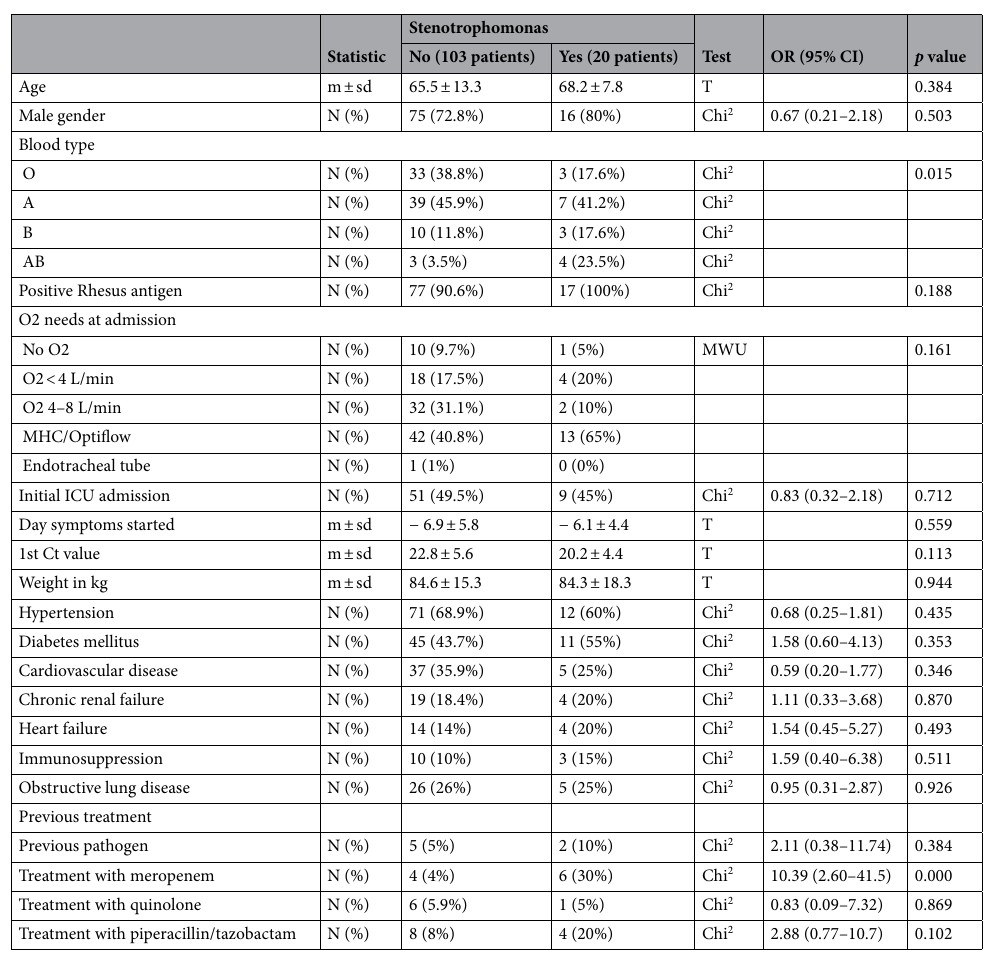
Table 2. Baseline clinical characteristics, medical history and risk factors in the 2 groups without and with Stenotrophomonas infection. Categorical data are presented as frequencies and percentages (N (%)); Continuous data not departing from normality assumptions are presented as mean and standard deviation (m ± sd). Chi 2 : Chi square test; MWU: Mann–Whitney U test. For binary data, the odds ratio with its 95% confidence interval were calculated [OR (95% CI)]. F: Fisher exact test. T: independent samples T